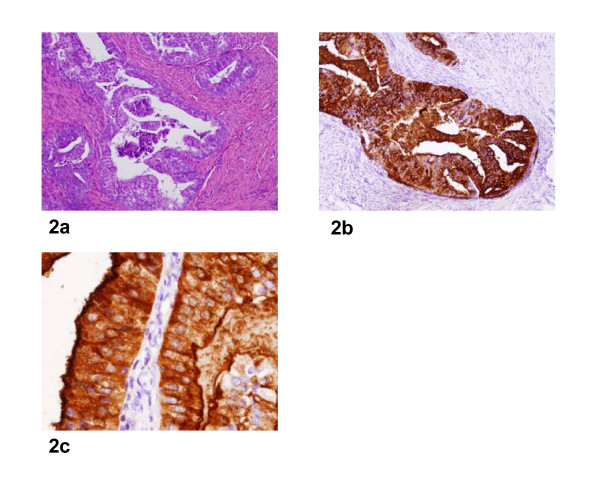
A, Endometrial mucinous adenocarcinoma (H&E, x10); B, MUC1 immunostain in endometrial mucinous adenocarcinoma showing A/C staining pattern (x10); C, MUC1 immunostain in endometrial mucinous adenocarcinoma showing A/C staining pattern (x40).